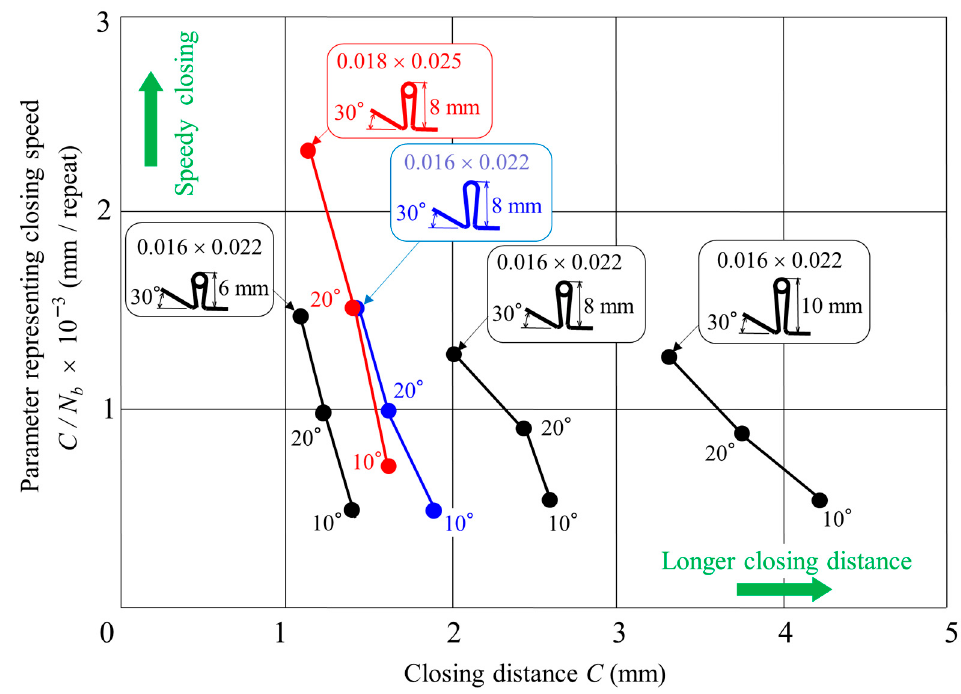
Figure 8. Relationship between closing distance C and equivalent closing speed C / N